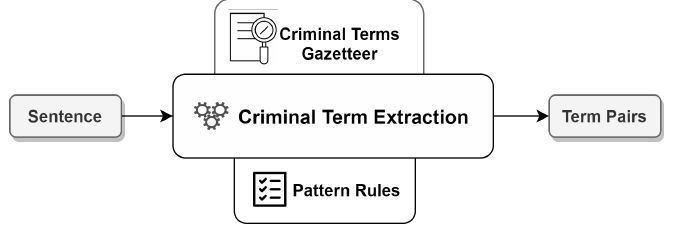
Figure 3. Criminal Term Extraction